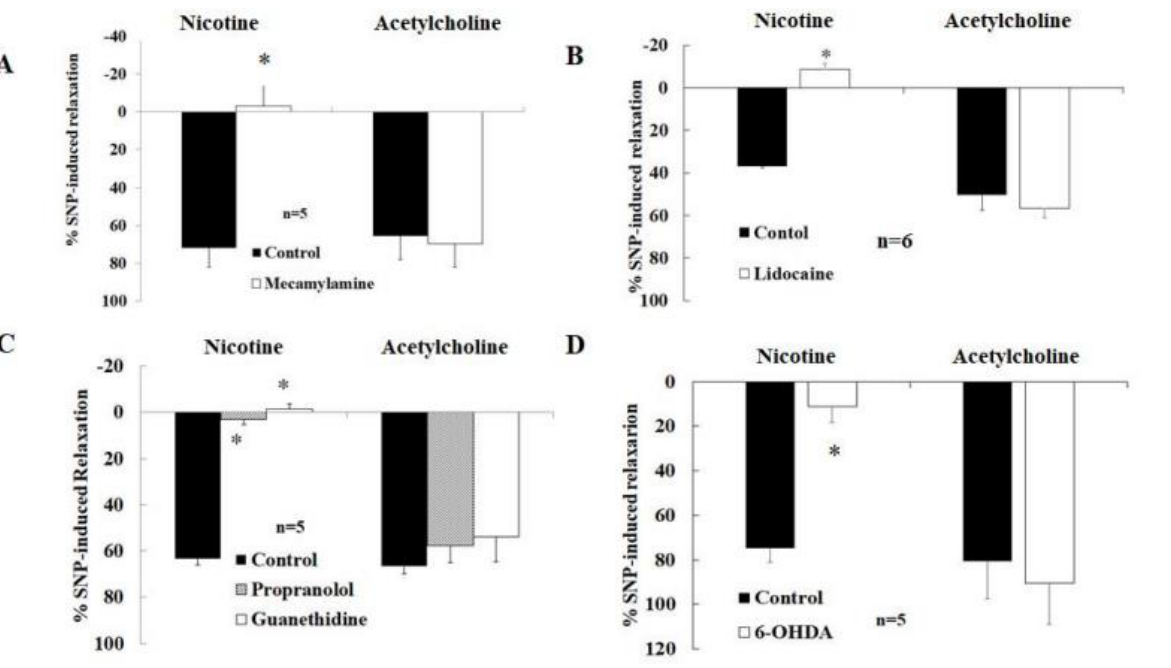
Figure 4. Role of the sympathetic nerve on nicotine-induced corpus cavernosum (CC) neurogenic relaxation. The active muscle tone of the CC was induced by phenylephrine (PE, 10 μM). Nicotine (50 μM)-induced relaxation was inhibited by pretreatment with mecamylamine (10 μM, n = 5, p < 0.05, ( A )), lidocaine (10 μM, n = 6, p < 0.05, ( B )), propranolol (10 μM, n = 5, p < 0.05, ( C )), and guan- ethidine (10 μM, n = 5, p < 0.05, C). In addition, nicotine-induced relaxation was inhibited by 6- hydroxydopamine (6-OHDA), causing chemical denervation ( n = 5, p < 0.05, ( D )). Acetylcholine (ACh)-induced relaxation was not affected by pretreatment drugs. ACh- and nicotine-induced CC smooth muscle relaxation were estimated as a percentage of sodium nitroprusside (SNP, 0.1 mM)- induced maximum relaxation. n , number of experiments. Values are means ± SD. Asterisks indicates a significant difference in the paired t -test (* p < 0.05) vs. the control group in ( A , B , D ). Asterisk indi- cate a significant difference in Bonferroni post-tests following ANOVA ( * p < 0.05) vs. control group in ( C ).